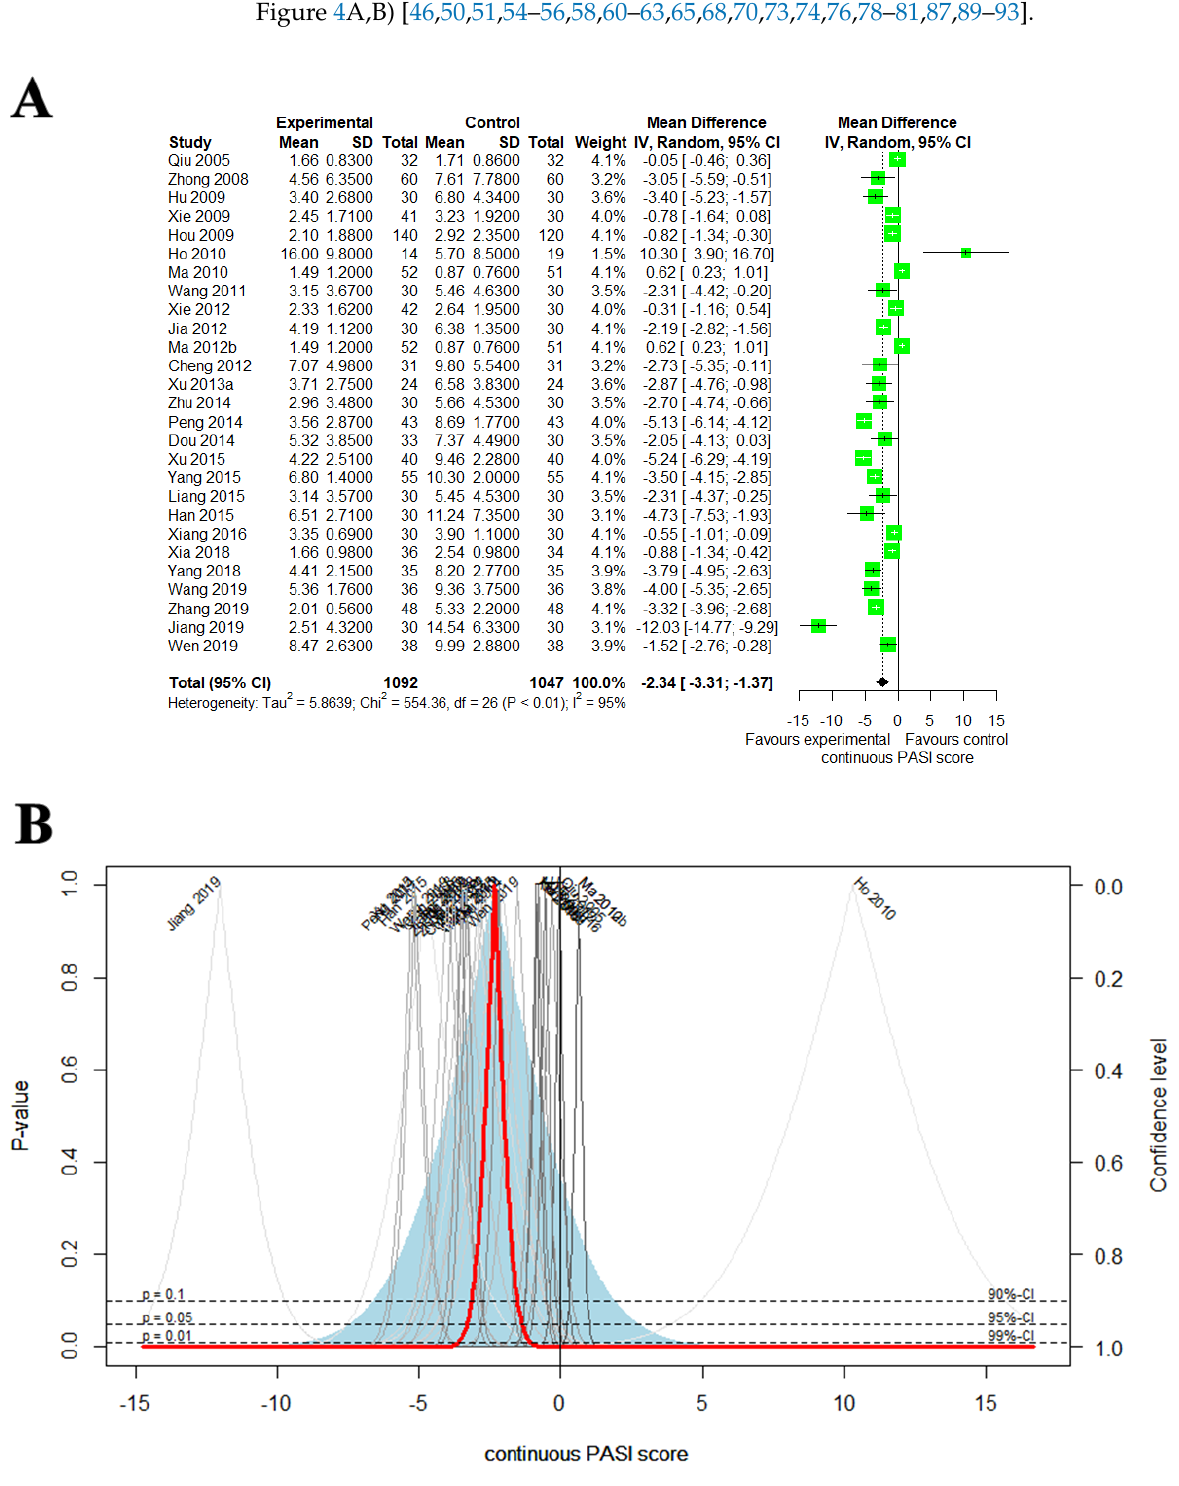
Figure 4. ( A ) Forest plot of the trials that compared EAHM with CM for continuous PASI score; ( B ) drapery plot of the trials that compared EAHM with CM for continuous PASI score.